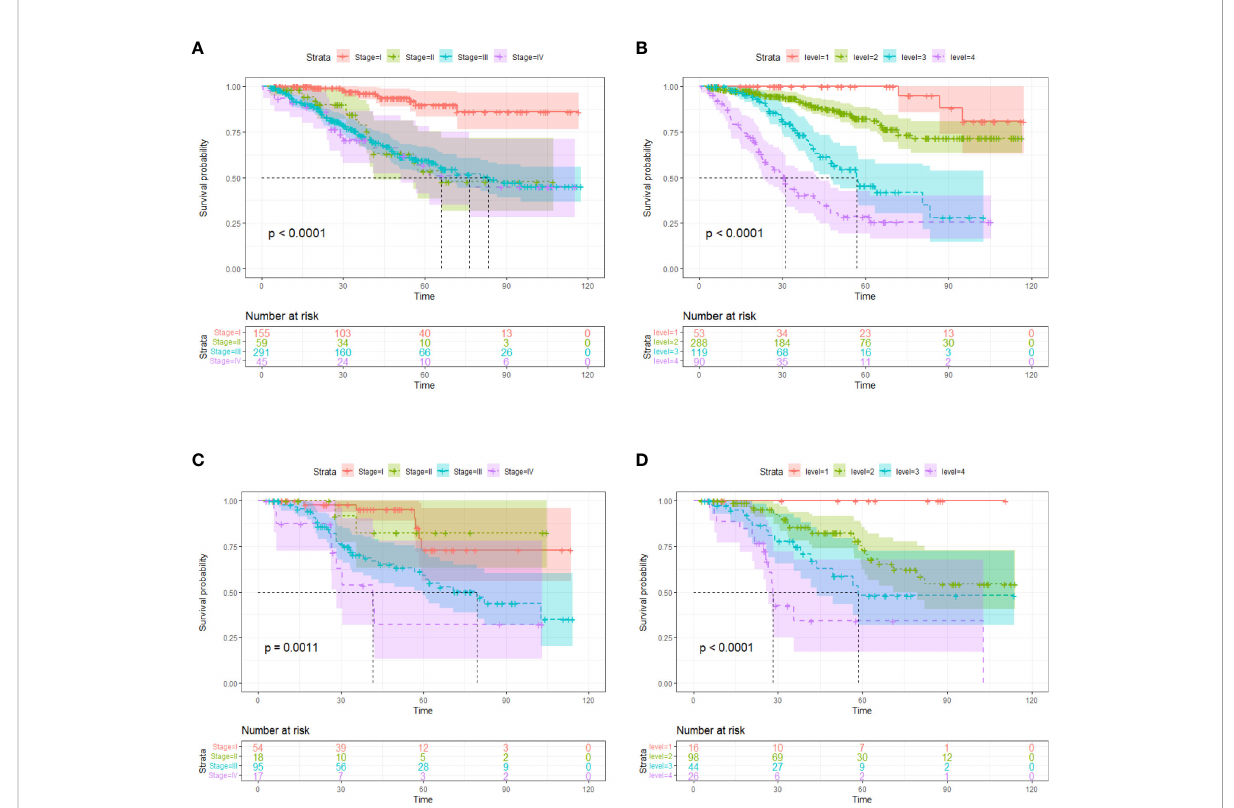
FIGURE 4 Kaplan-Meier survival curves according to tumor stages in training cohort (A) and validation cohort (C) . Kaplan-Meier survival curves based on risk strati fi cation according to image score in training cohort (B) and validation cohort (D) . The shadow indicates the 95% con fi dence